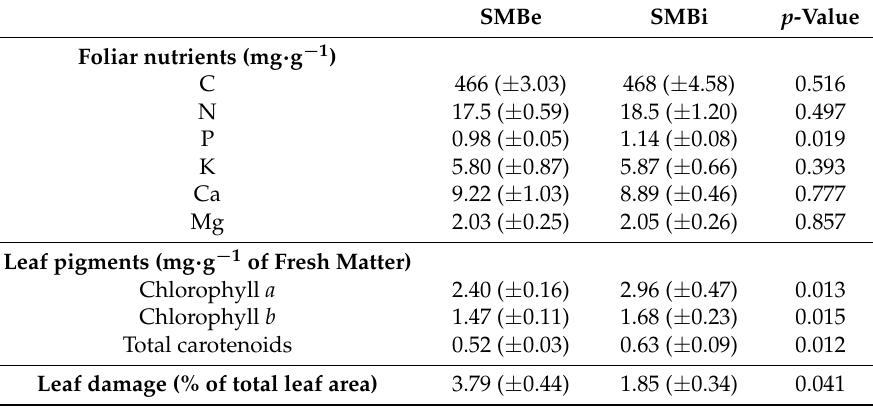
Table 5. Foliar nutrients, leaf pigments and leaf damage of sugar maple seedlings in sugar maple-American beech (SMBe) and sugar maple-birch spp. (SMBi) stands.